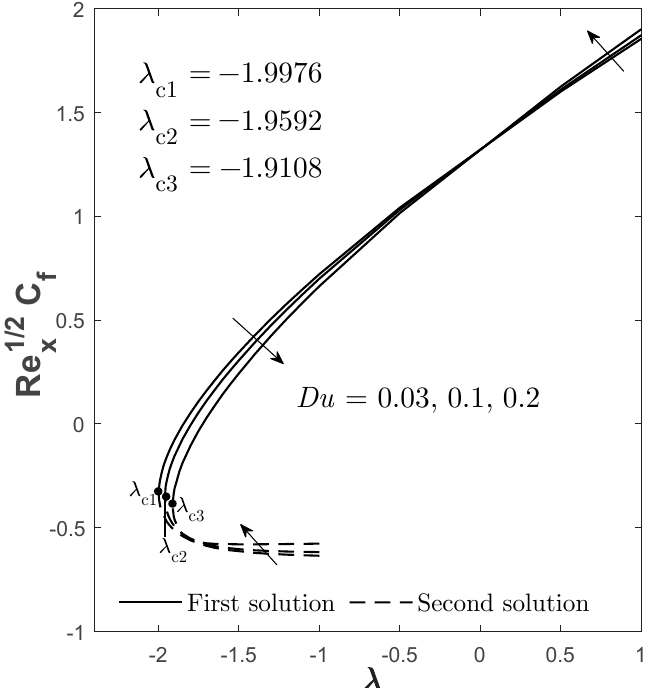
Figure 5. Re 1/2 x C f for varied Du when N = Rd = Sc = Sr = 1, φ 2 = 0.01, and Bi = C for varied Du when Figure 5. 1/2 Re x f C for varied Du when 1 N Rd Figure 5. 1/2 Re x f